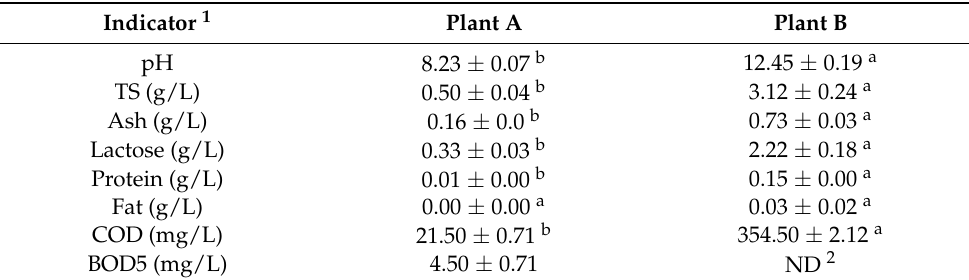
Table 1. Chemical characteristics of white wastewater generated during the cleaning procedure of pasteurizers from two Canadian dairy plants (A and